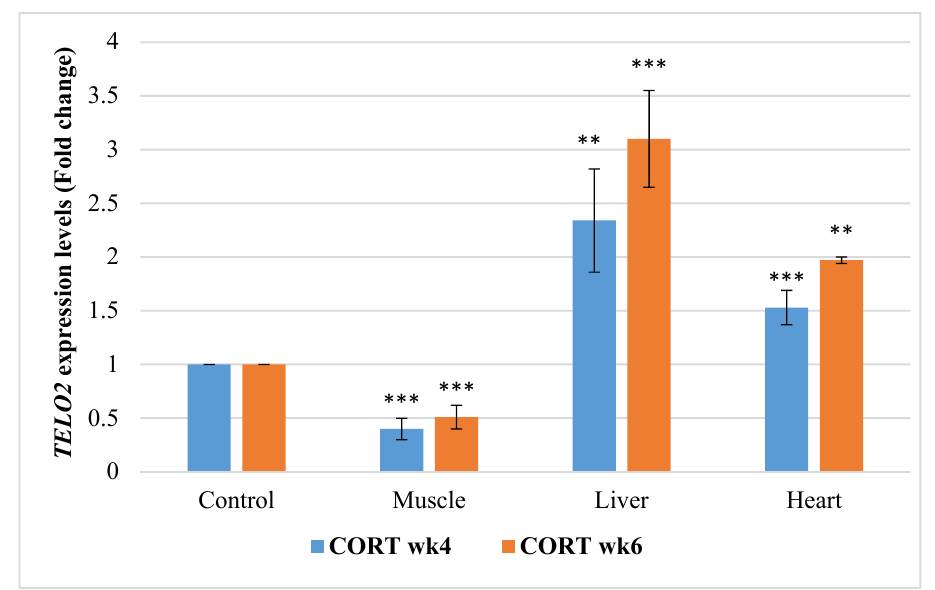
Figure 3. Expression profile of telomere maintenance gene 2 ( TELO2 ) in the muscle, liver, and heart at week 4 and